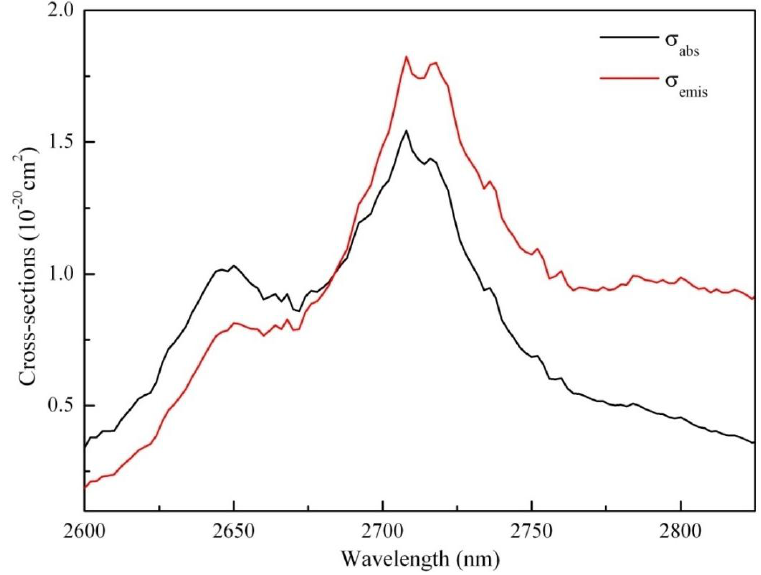
→ 4 I in TF 11/2 13/2